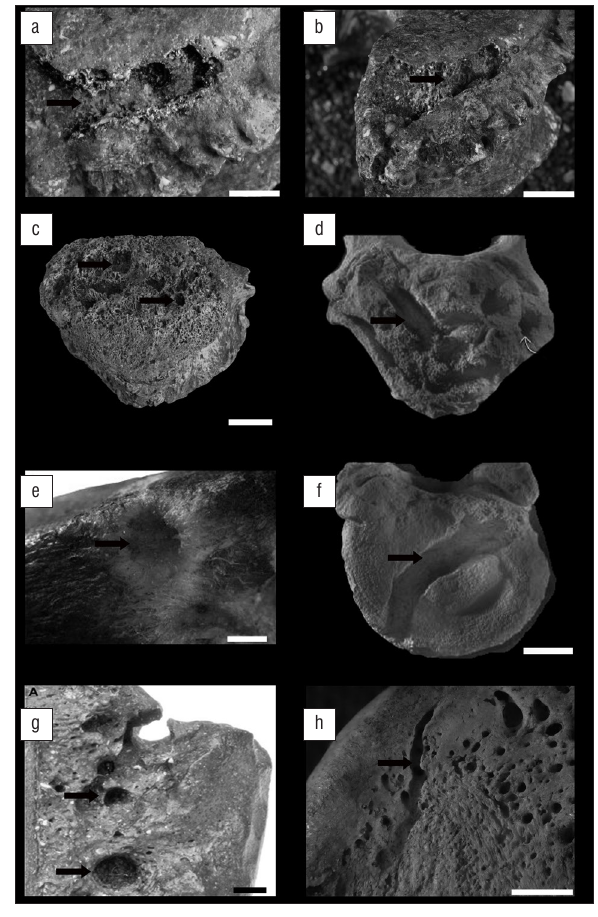
Figure 6: Insect traces excavated into the L5 vertebrae on StW 431 are indicated by arrows (a and b); (c) circular boring on a cercopithecus vertebra from Cooper’s D; (d, f) furrows attributed to Dermestes maculatus from the Jurassic period 34 ; (e) hole produced by the termite Trinervitermes trinervoides 21 ; (g) holes produced by dermestids under experimental conditions 39 ; and (h) furrow produced by the termite T. trinervoides 21